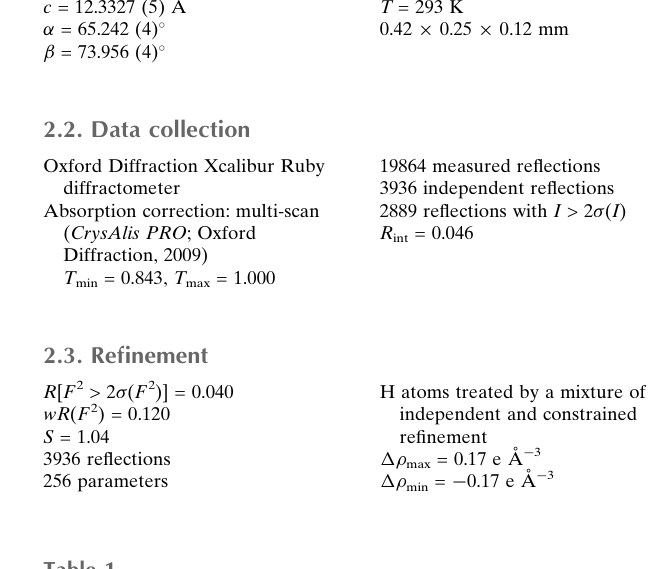
Hydrogen-bond geometry (A˚ , (cid:3)